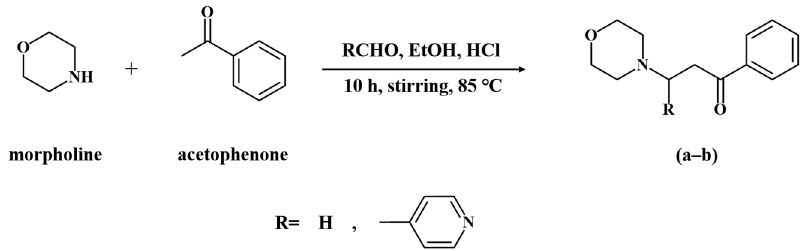
Figure 1. Scheme for synthesizing morpholinyl Mannich bases: ( a ) MPO and ( b ) MPPO. 3-morpholino-1-phenylpropan-1-one (MPO): White solid (85%, yield); mp 143–146 ◦